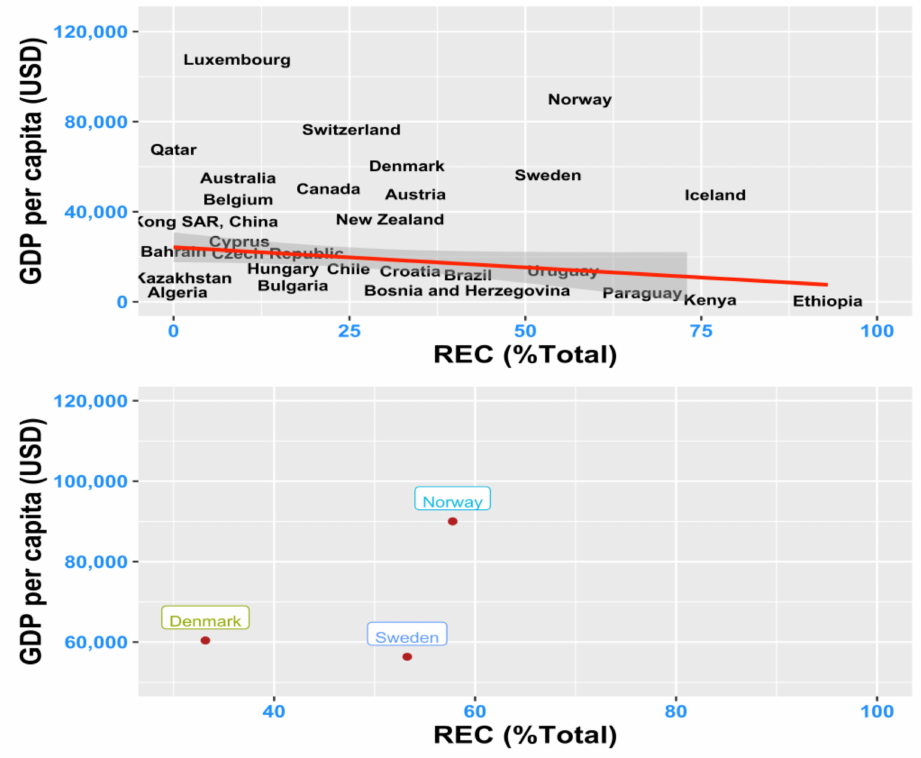
Figure 1. Renewable energy consumption (% total energy utilization) and income (GDP per capita), most recent year of available data per country (Panel A); countries with GDP >50,000 USD and REC >30% of total energy utilization (Panel B). Source of data: World Bank’s Development Indicators (WDI)